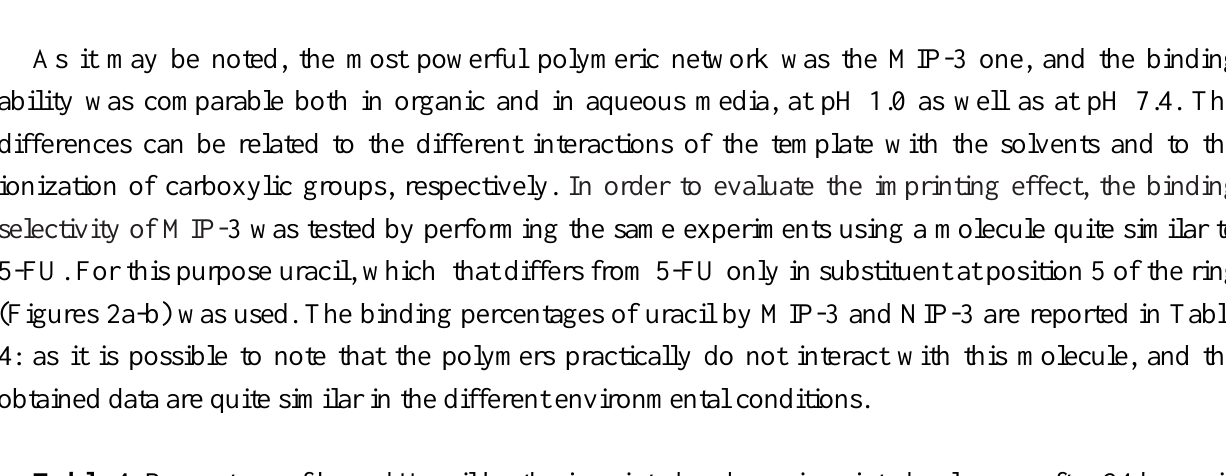
Table 4. Percentage of bound Uracil by the imprinted and non-imprinted polymers after 24 hours in organic (i.e., acetonitrile) aqueous media (i.e., pH=1.0 and